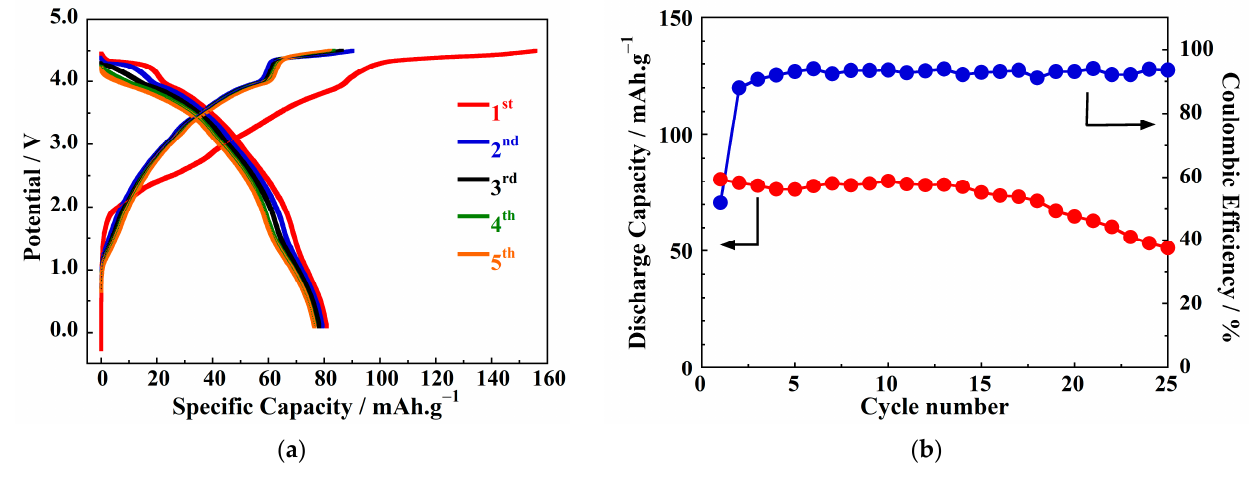
Figure 8. Cycling performance of hard carbon||NMC-900 full-cell. ( a ) The voltage profile and ( b ) evolution of capacity and Coulombic efficiency with cycle number.